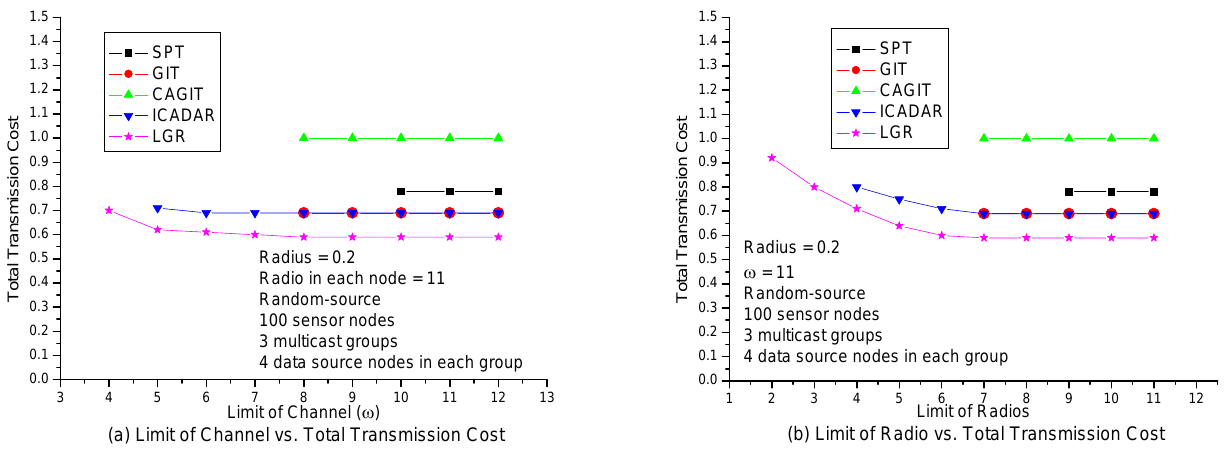
Figure 9. Performance comparison with respect to the channel and radio in random-source.